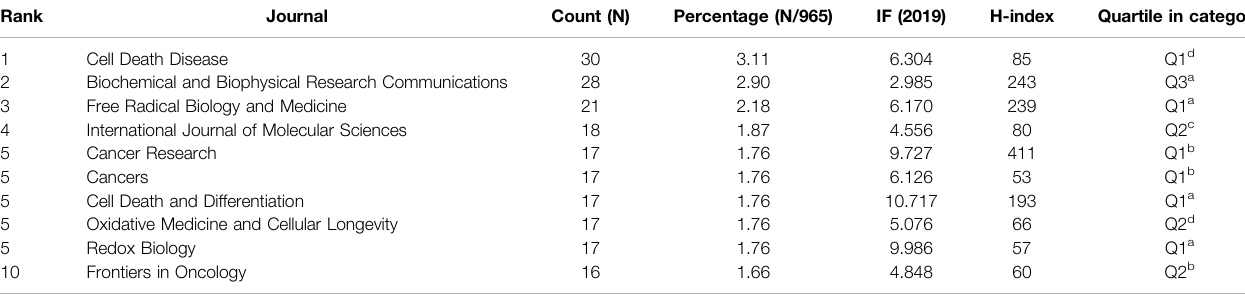
TABLE 3 | Top 10 productive journals and co-cited journals related to ferroptosis in cancer research.